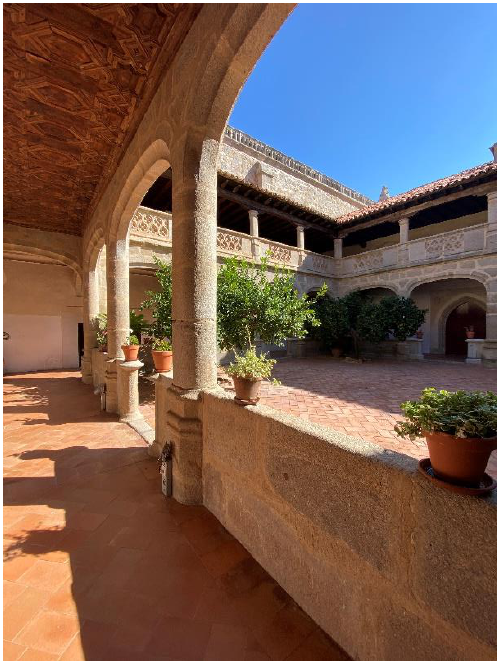
Figure 3. View of the galleries of the monastery’s cloisters, 2020.